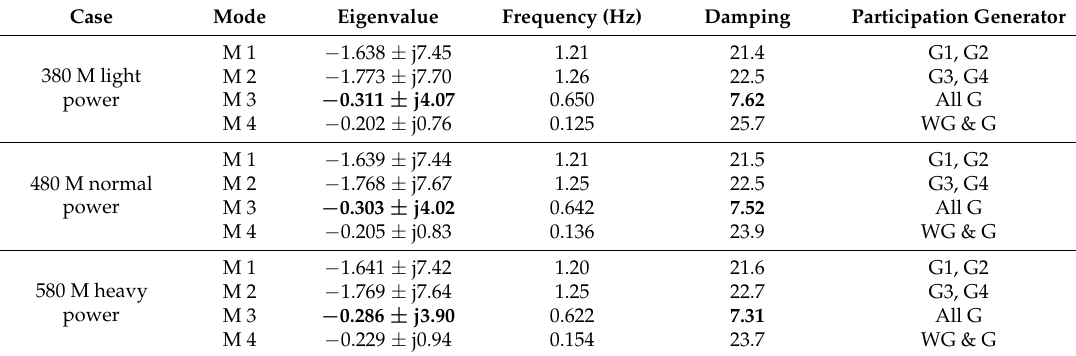
Table 2. The oscillation modes with PSSs only.